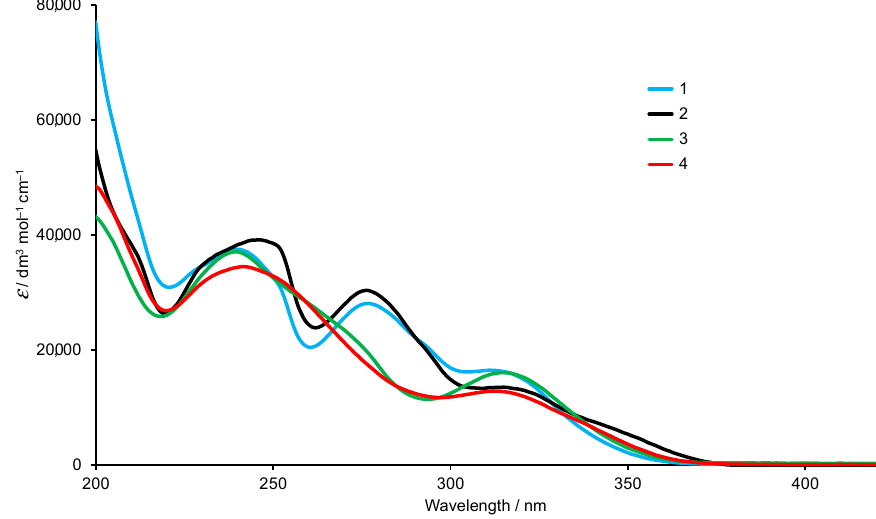
Molecules 2023 , 28 , x FOR PEER REVIEW 6 of 17 − 5 mol dm − 3 ). Figure 3. Absorption spectra of compounds 1–4 in MeCN (2.0 × 10 –5 mol dm –3 ). Figure 3. Absorption spectra of compounds 1–4 in MeCN (2.0 × 10